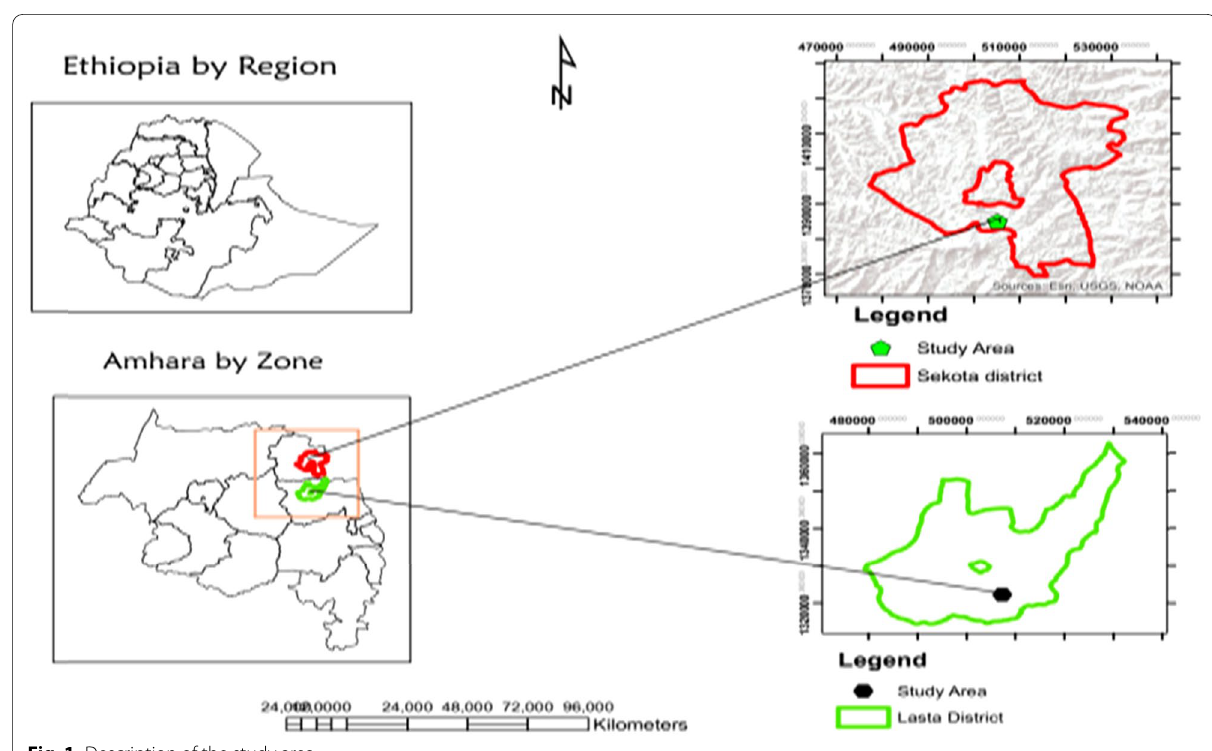
Fig. 1 Description of the study area